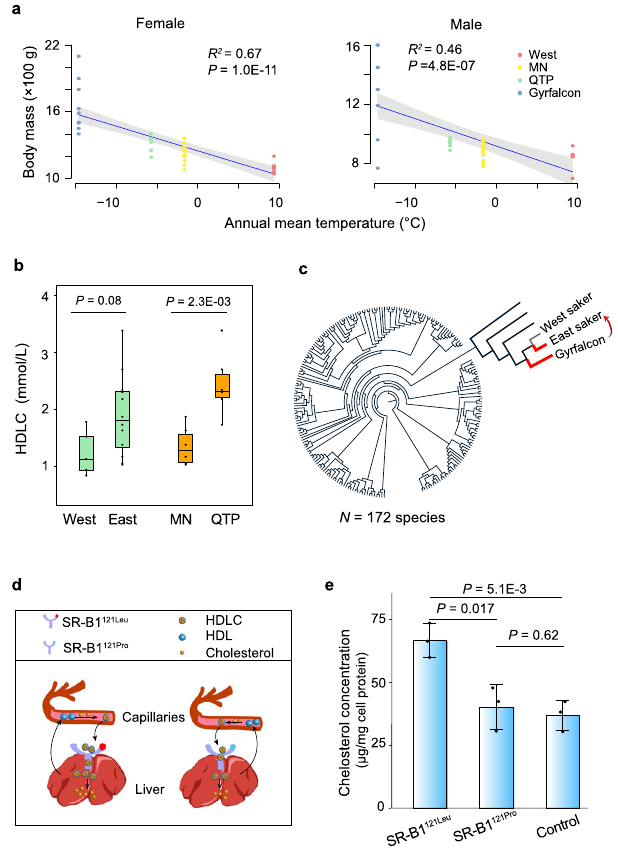
Fig. 3 | Higher body mass in East sakers due to introgressed SR-B1 121Leu from gyrfalcons. a Correlation between body mass and annual mean temperature for both female (left; 10 gyrfalcons, 34 sakers including 11 from West, 15 from MN and eight from QTP) and male (right; nine gyrfalcons, 34 sakers including eight from West, 16 from MN and ten from QTP) falcons using a linear regression model. The mean(blueline)and95%CI(grayband)areshown.Signi fi cancelevelwascalculated using F test. b High-density lipoprotein cholesterol (HDLC) concentration of plasma in comparisons of West ( N =6 biologically independent samples) and East sakers ( N =12 biologically independent samples), MN ( N =6 biologically indepen- dent samples) and QTP sakers ( N =6 biologically independent samples). A two- sided t test was used. In the box plots, the center line represents the median, whiskersrepresentmaximum and minimum values, and boxboundaries represent 75th and 25th percentiles. c Amino acid on SR-B1 121 in 172 avian species; black and red branches represent species featuring SR-B1 121Pro and SR-B1 121Leu ,